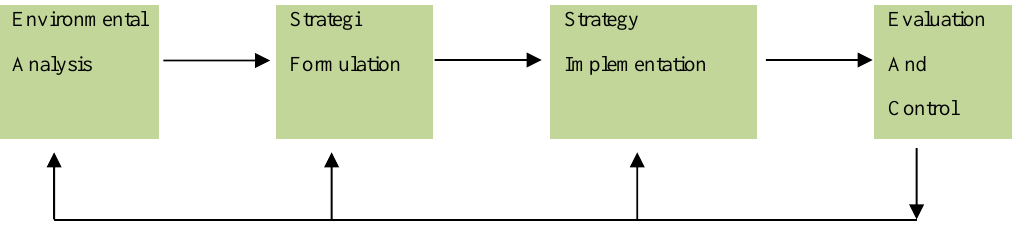
Figure 1: Basic Model of Strategic